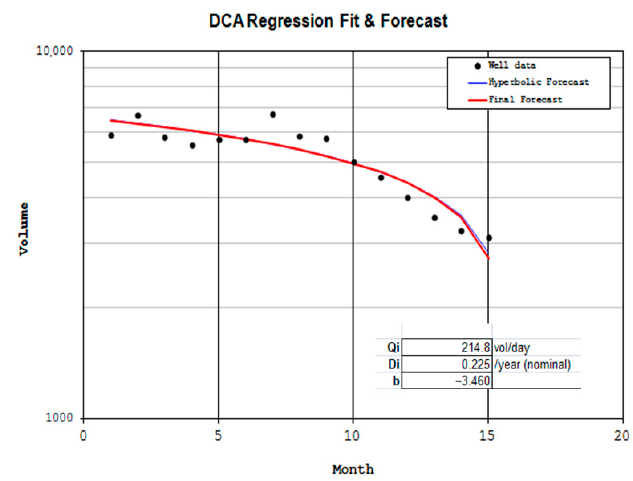
Figure 7. Decline curve analysis (DCA) least squares regression solver-fit of 15 month historic production data. Without constraining solver solutions to positive values, the regression returns a negative b -value.